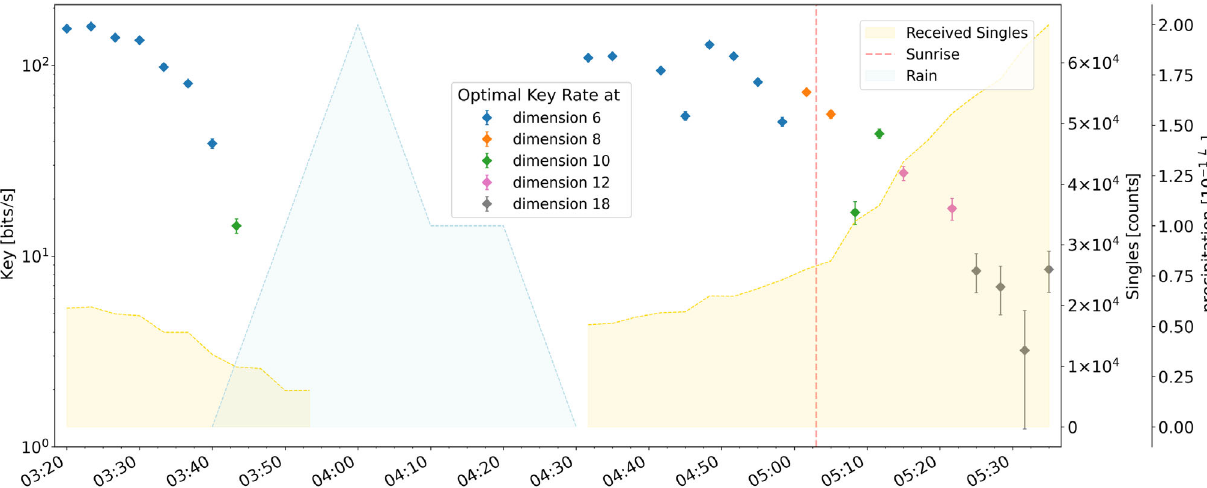
FIG. 3. Achievable key rate. The achievable key rates are plotted over the measurement time of the experiment. The key rate is evaluated for data obtained by integrating over 200 s blocks of time-tagged detector event streams. For each interval the optimal nonzero key-rate value is plotted, using different colors to indicate the corresponding best dimensionality. The orange line indicates sunrise, and we show the rain data and single photon counts as a measure for background radiation. From the plot it can be clearly seen that our noisy free-space channel can be used to distribute a cryptographic key under various noise conditions, even for considerable time after the break of the day. Overall, the dimension of the discretization which achieves the largest key rate increases with the increasing background radiation, thus demonstrating superior noise resistance of high-dimensional